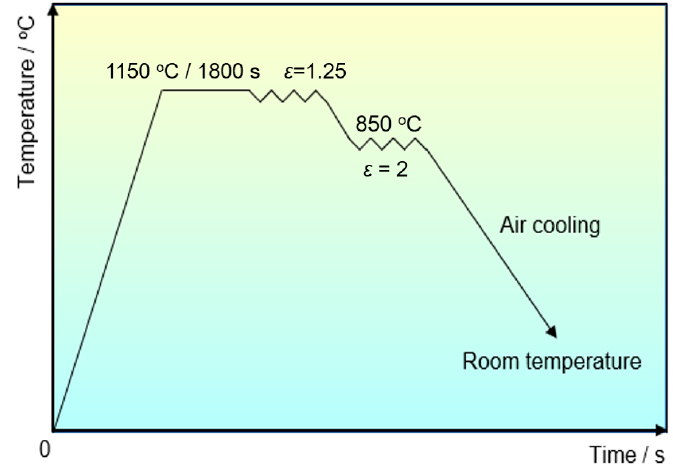
Figure 1. Forging process and the corresponding parameters for experimental steels .